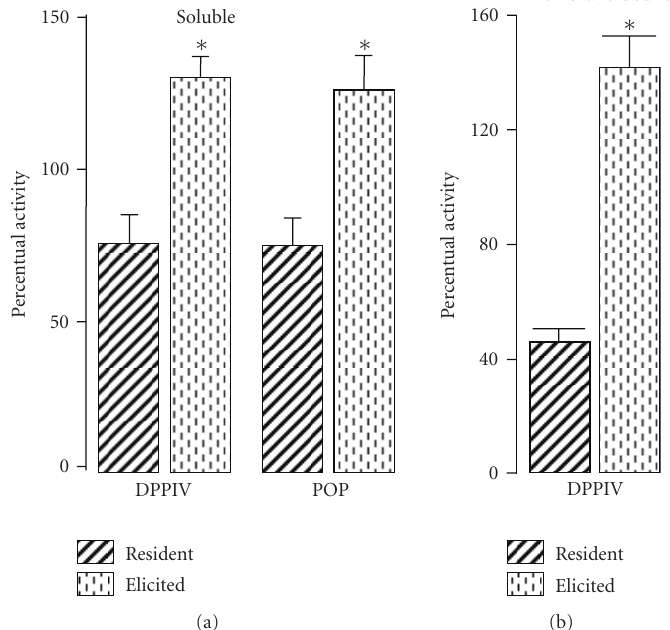
Figure 5: Percentual activity of soluble and membrane-bound dipeptidyl peptidase IV (DPPIV) and prolyl oligopeptidase (POP) activities in resident and thioglycollate-elicited murine macrophages from methotrexate plus cyclosporine-treated in relation to the respective control (100%). Values are means ± SEM from 5 animals (assays made in triplicate). ∗ P < . 001 in comparison to control (unpaired two-sided Student’s t